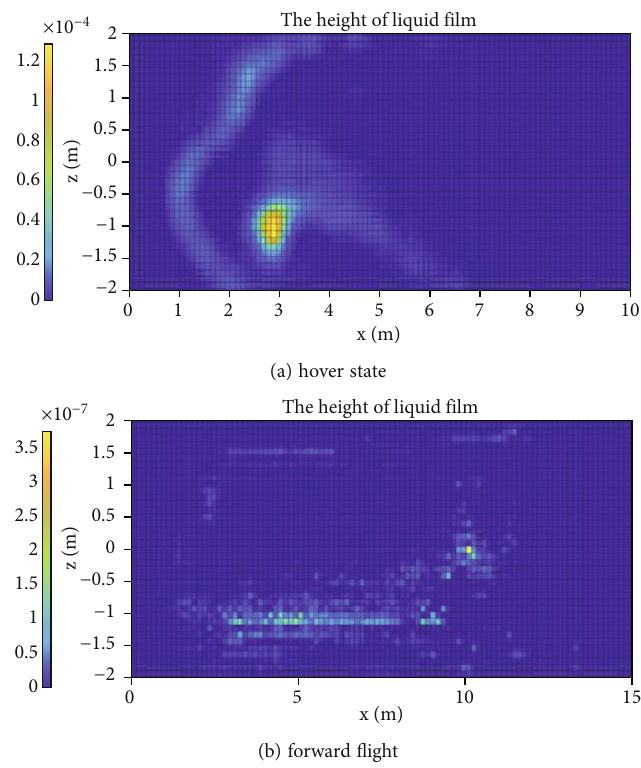
Figure 10: The height of deposited liquid fi lm on the ground when velocity is 3 m/s.